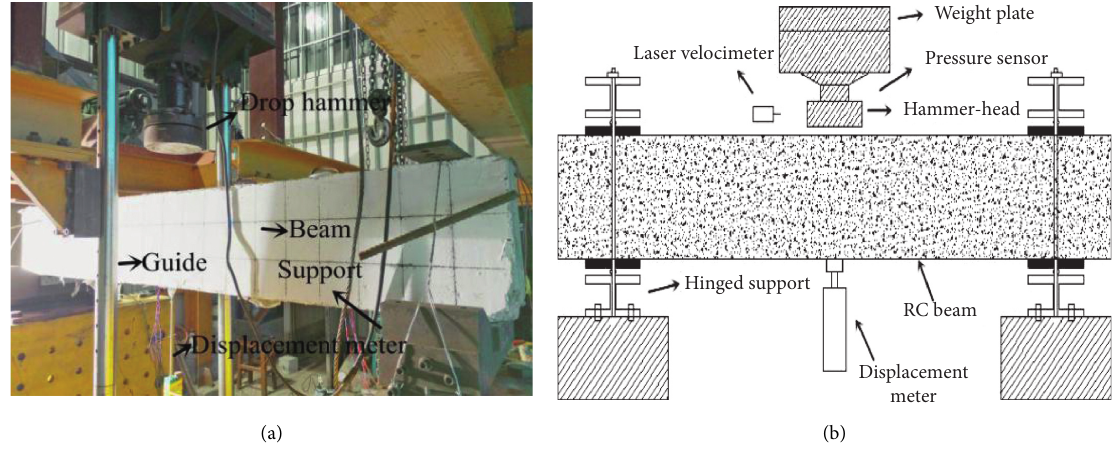
Figure 2: Falling weight impact test device (mm).